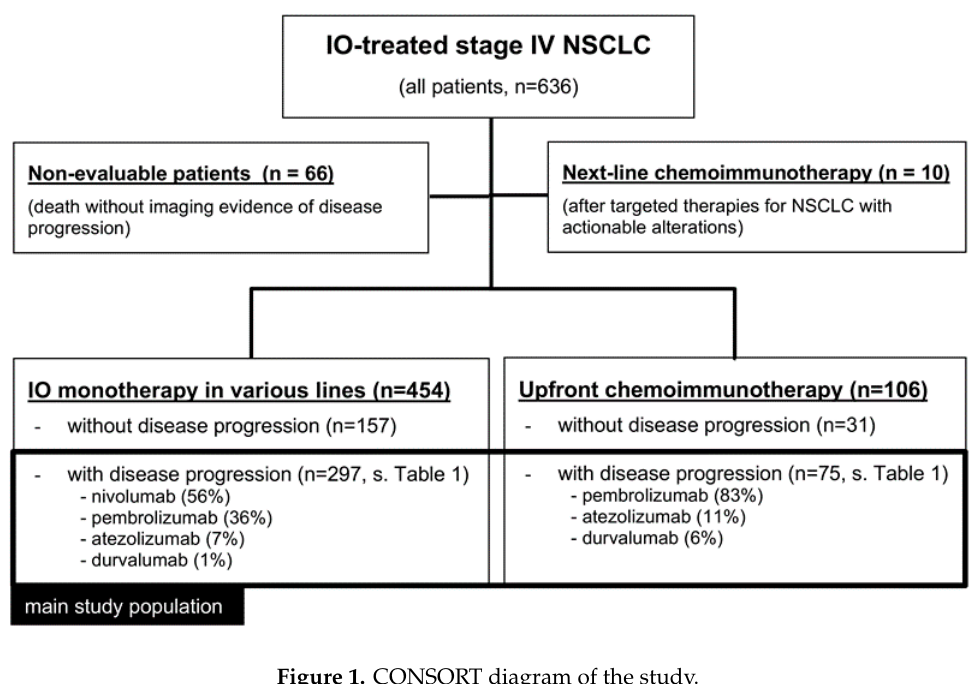
Figure 1. CONSORT diagram of the study.